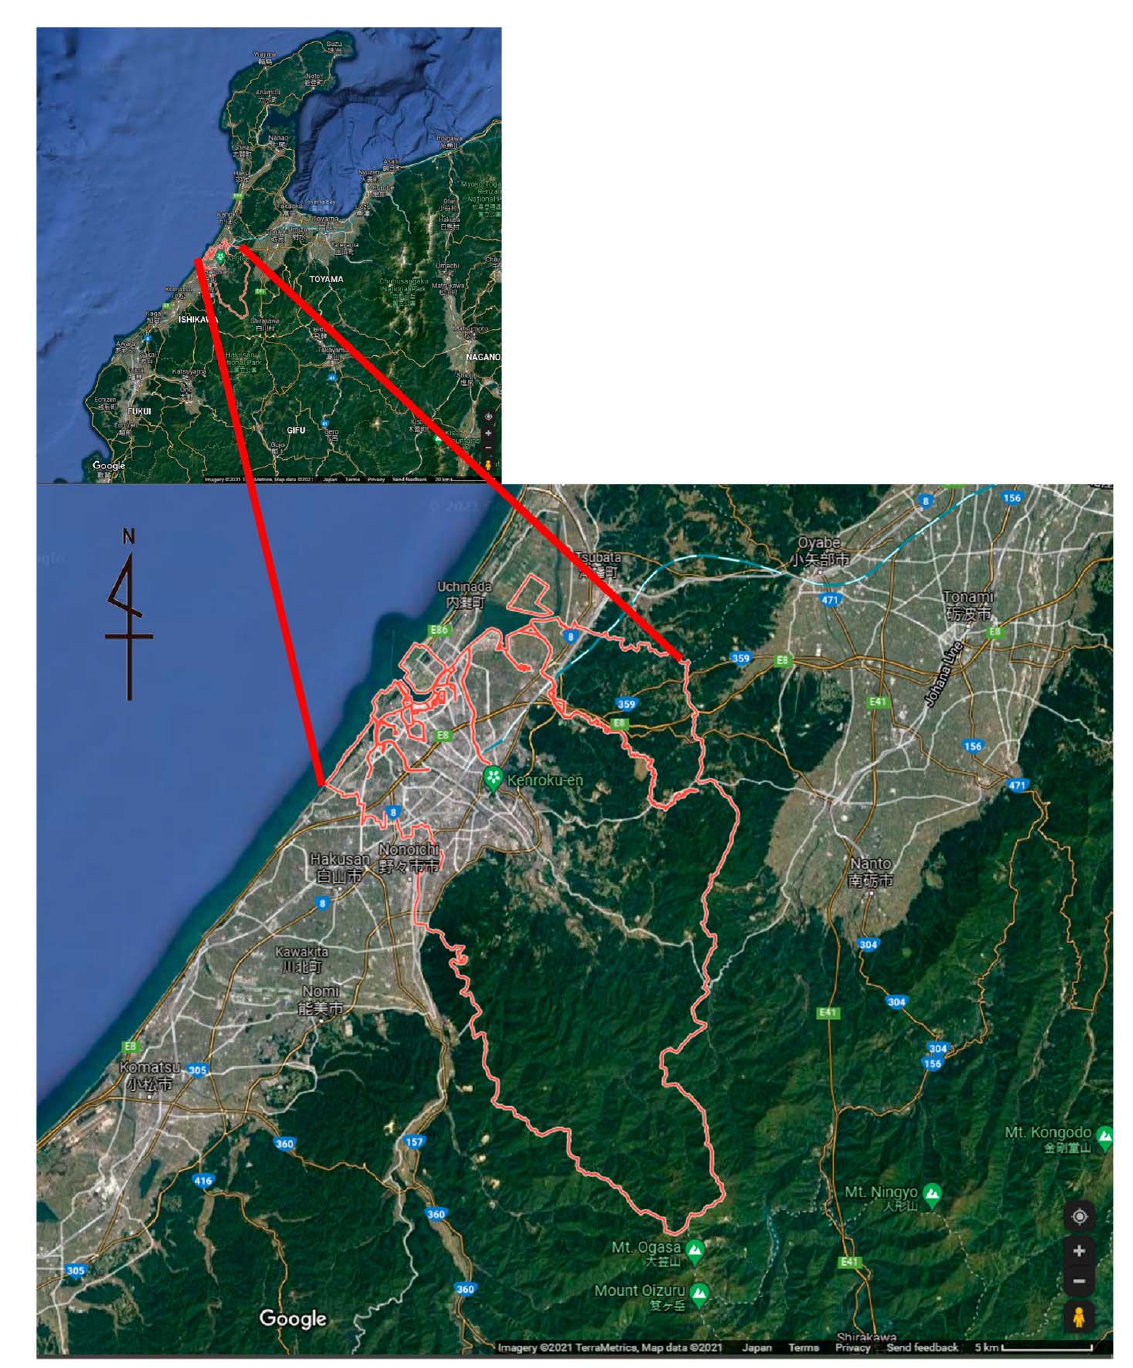
Figure 1. Location of Kanazawa City in Ishikawa Prefecture,